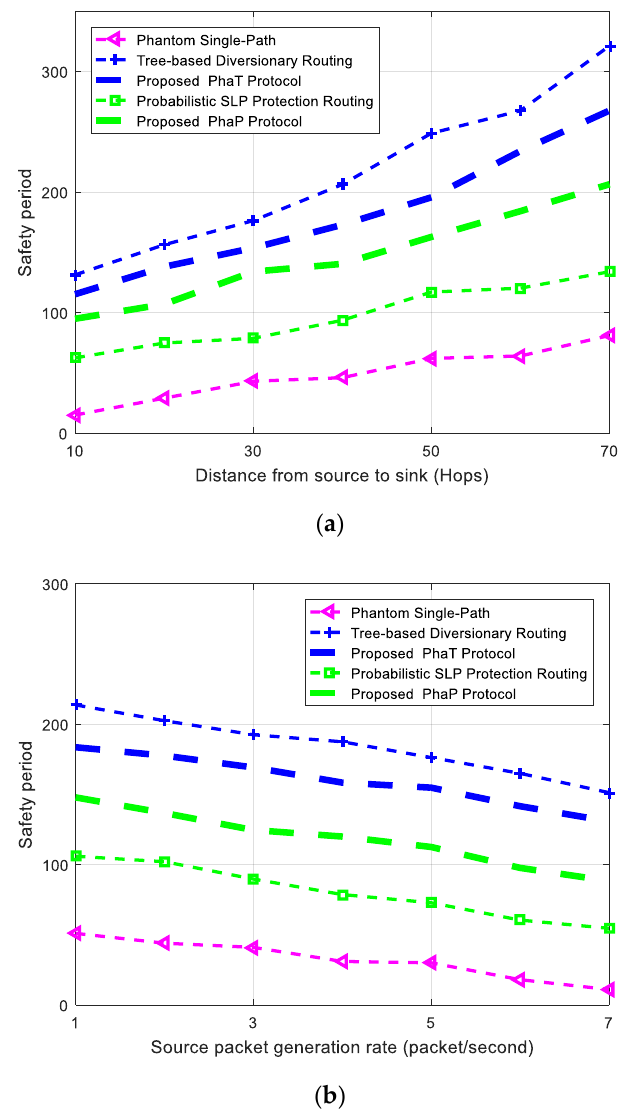
Figure 5. Privacy performance of the protocols. ( a ) Safety period against source – sink distance. ( b ) Safety period against source packet generation rate.